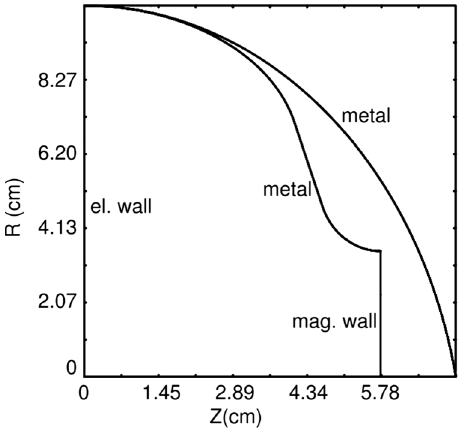
equator.FIG. 6. Example of two cavities with equal frequencies, equal R eq , equal radii of curvature